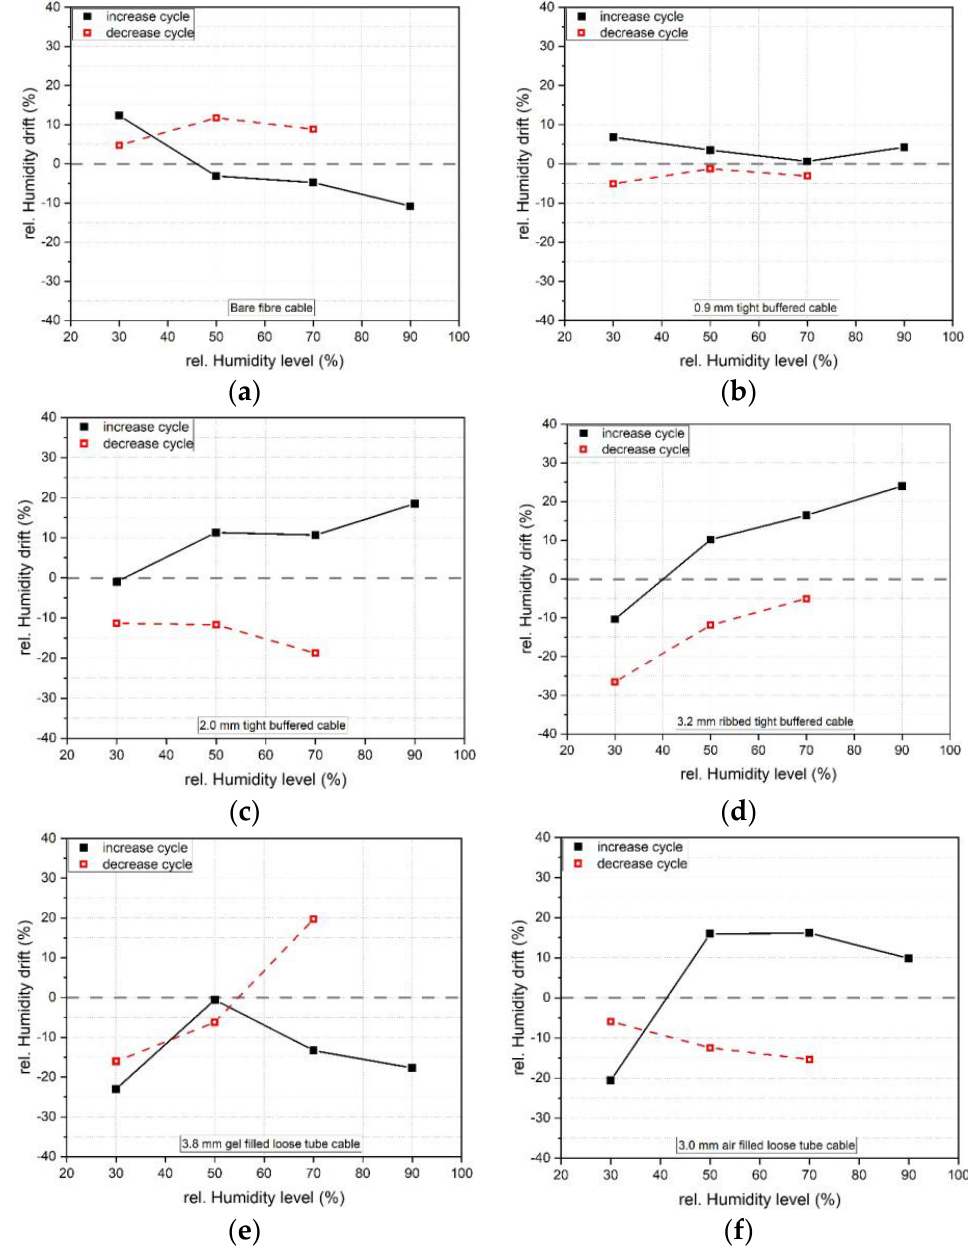
Figure 13. Humidity drift over time of the fibre optic cables at each humidity level (30 – 90% rel H), ( a ) bare fibre, ( b ) 900 μm tight buffered, ( c ) 2.0 mm tight buffered, ( d ) 3.2 mm ribbed tight buffered, ( e ) 3.8 mm gel filled loose tube and ( f ) 3.0 mm air filled loose tube cable.